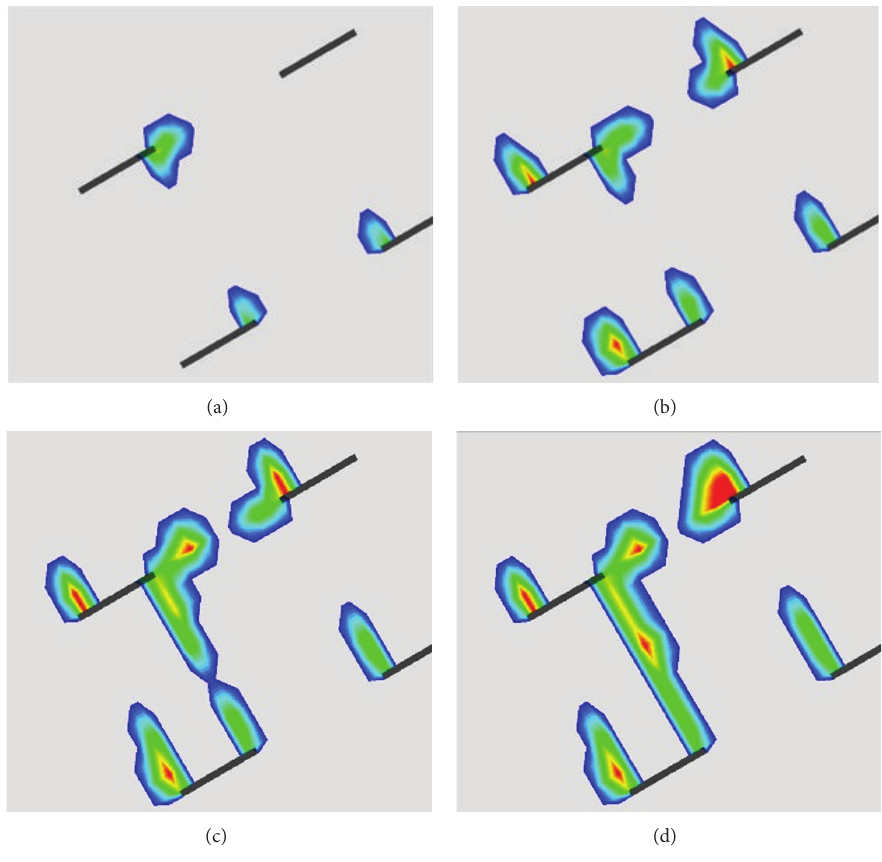
Figure 7: Damaged area expansion process at crack tips.